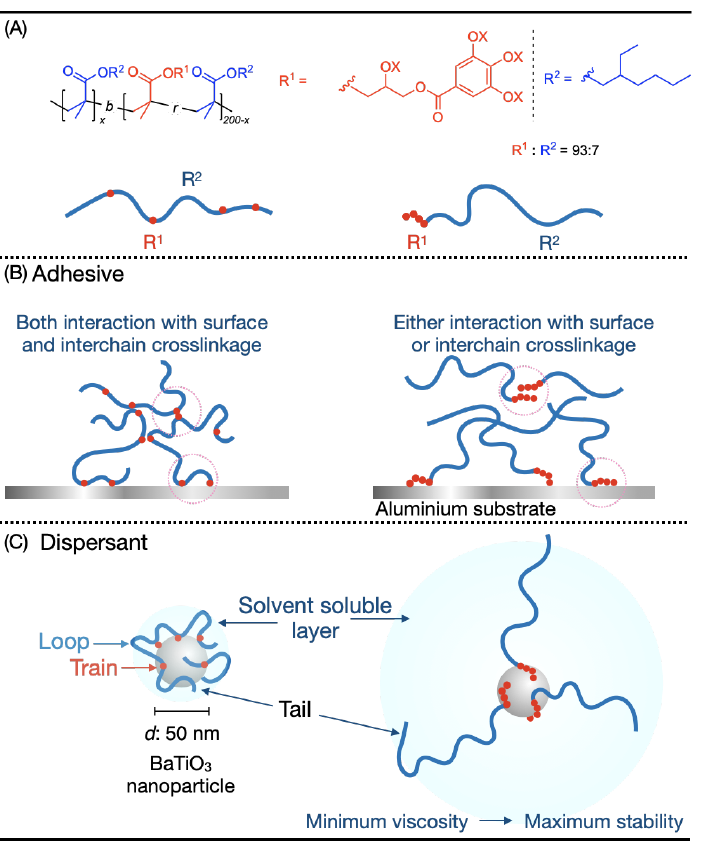
Figure 5. ( A ) Abbreviated structures of the copolymers. ( B ) Model structure showing copolymers bonding to aluminum plates. ( C ) Model structure showing copolymers adsorbing on a BaTiO 3 nanoparticle.